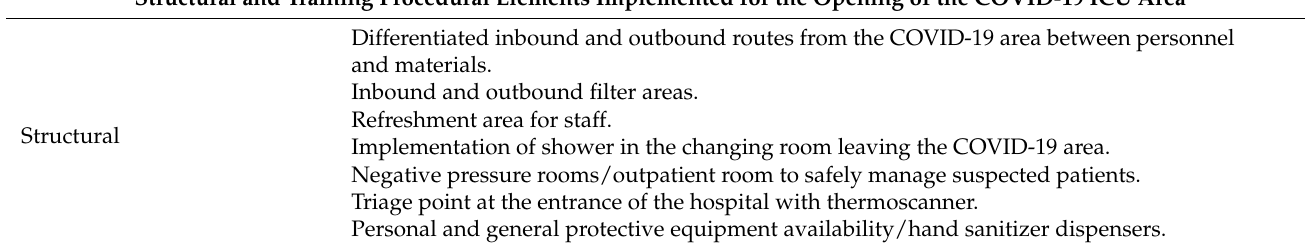
Structural and Training Procedural Elements Implemented for the Opening of the COVID-19 ICU Area